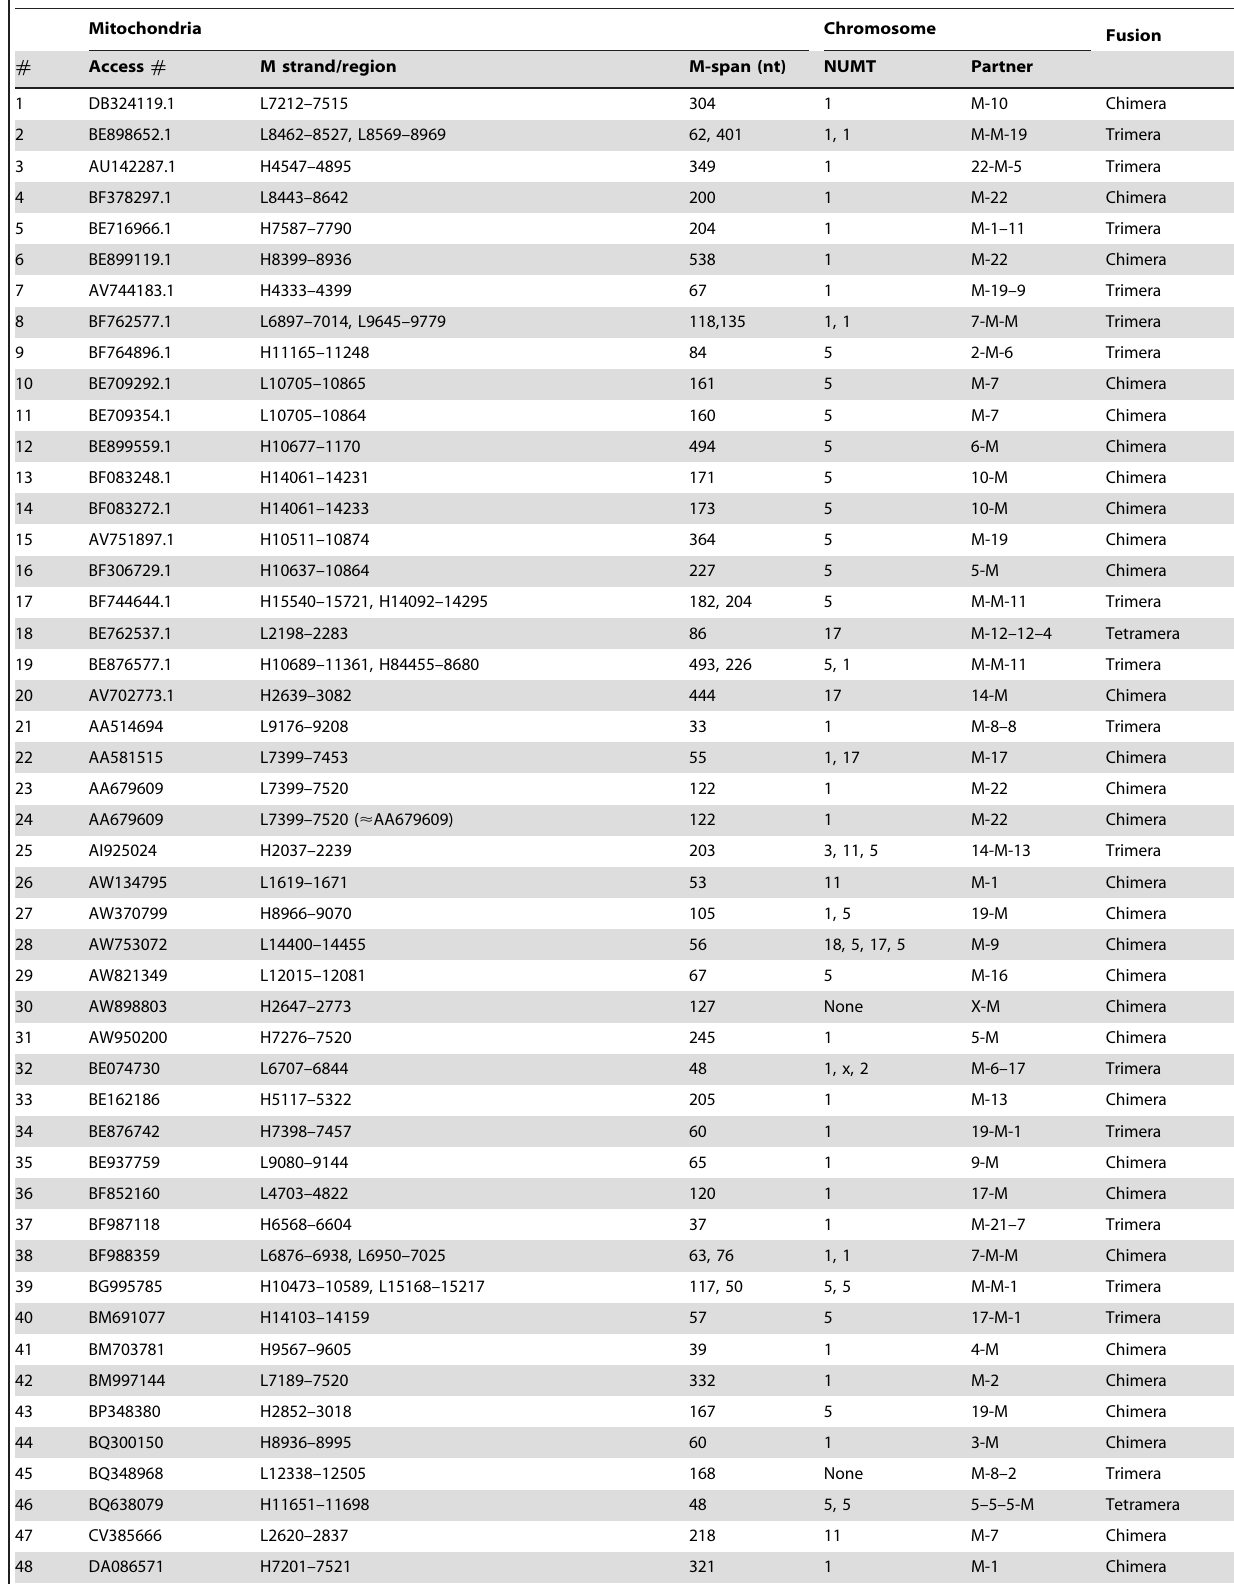
Table 3. Chimeric, trimeric or tetrameric ESTs that contain mitochondrial sequence.